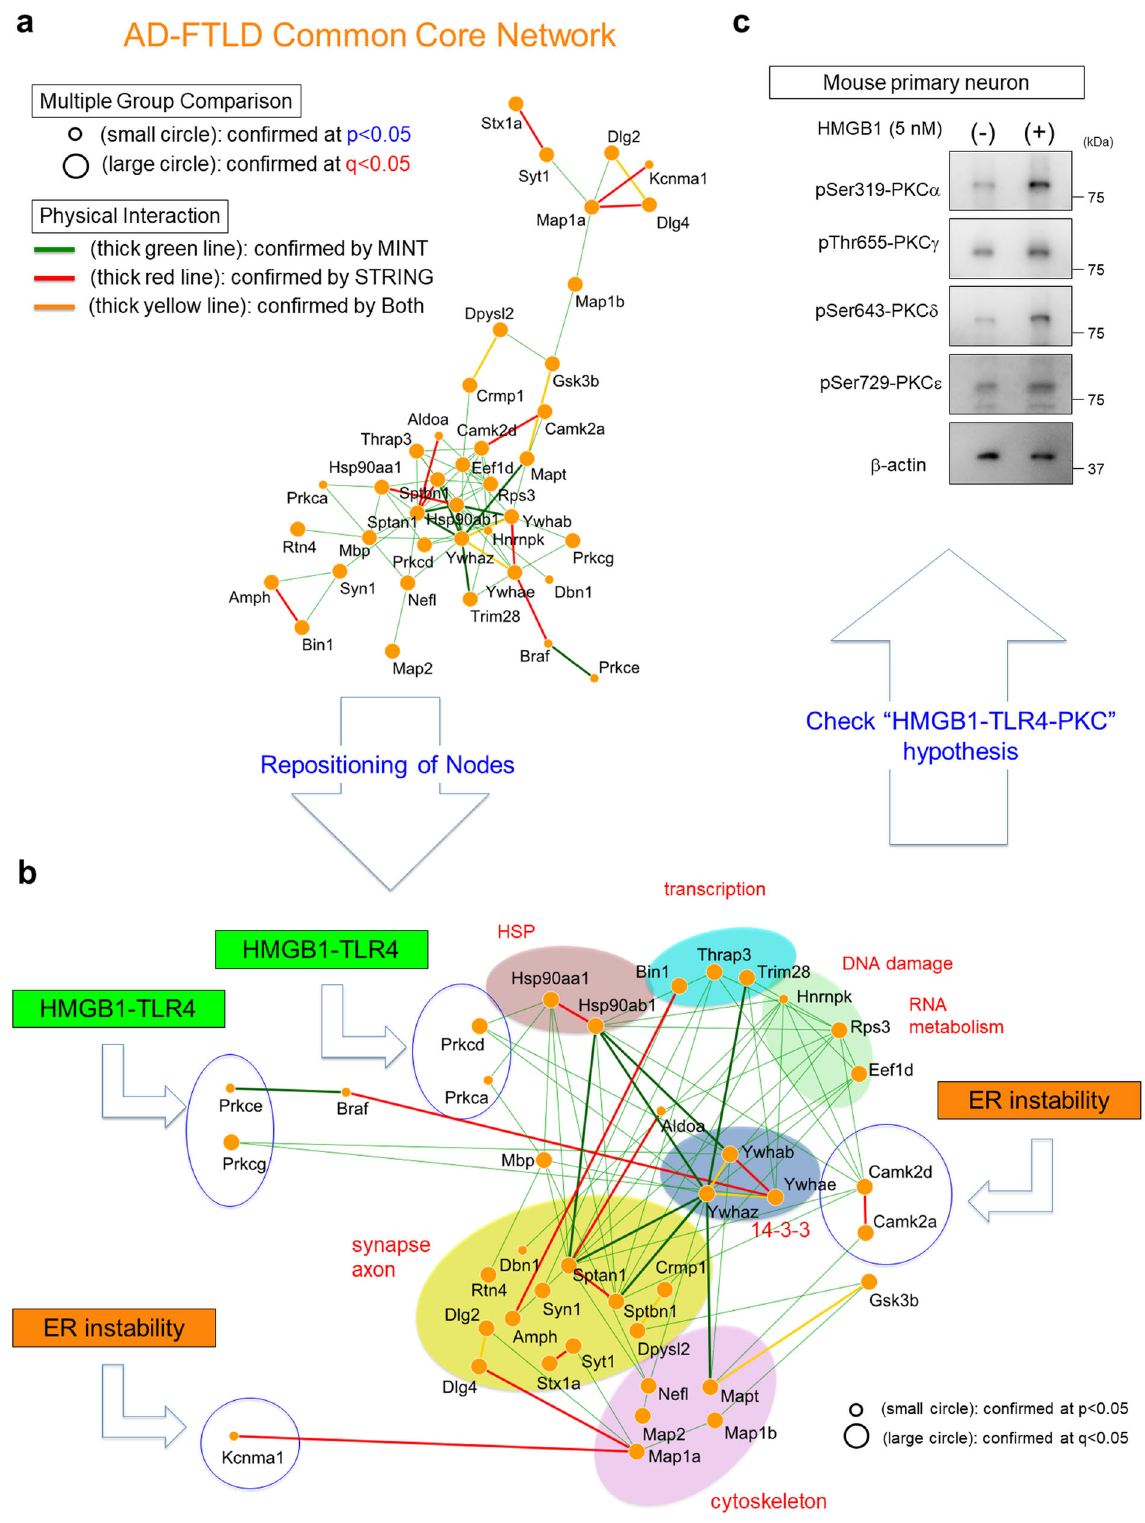
Fig. 2 Function-based analysis of AD-FTLD common core network. a AD-FTLD common core network was further examined by multiple group comparison and physical interaction-based PPI. Small circles were selected only by p values ( p < 0.05 in Welch ’ s test) while large circles were selected also by q values ( q < 0.05 in Welch ’ s test with post hoc BH procedure). The thick green line indicates an edge whose physical interaction was supported by MINT. The thick red line indicates an edge whose physical interaction was supported by STRING. The thick yellow line indicates an edge whose physical interaction was supported both by MINT and STRING. b Next, nodes were repositioned based on protein function and clustered into functional groups. The analysis indicates the gates through which HMGB1-TLR4 or ER-derived Ca 2 + signals enter the common core network. c Western blots of mouse cortical neurons (E15) in primary culture treated with human ds-HMGB1 (HMGBiotech) reveal activation of PKCs. PKC α and PKC δ are activated more prominently.